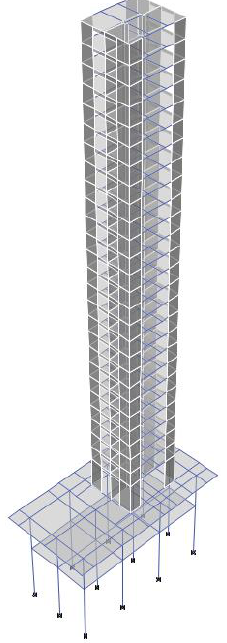
Figure 2. Simplified structure modeling.